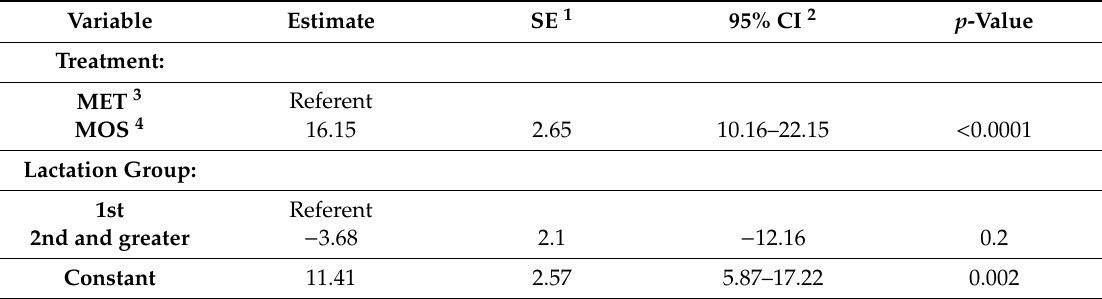
Table 3. Multivariable linear regression comparing plasma half-life (hours) between MET- and MOS-treated cows. Variable